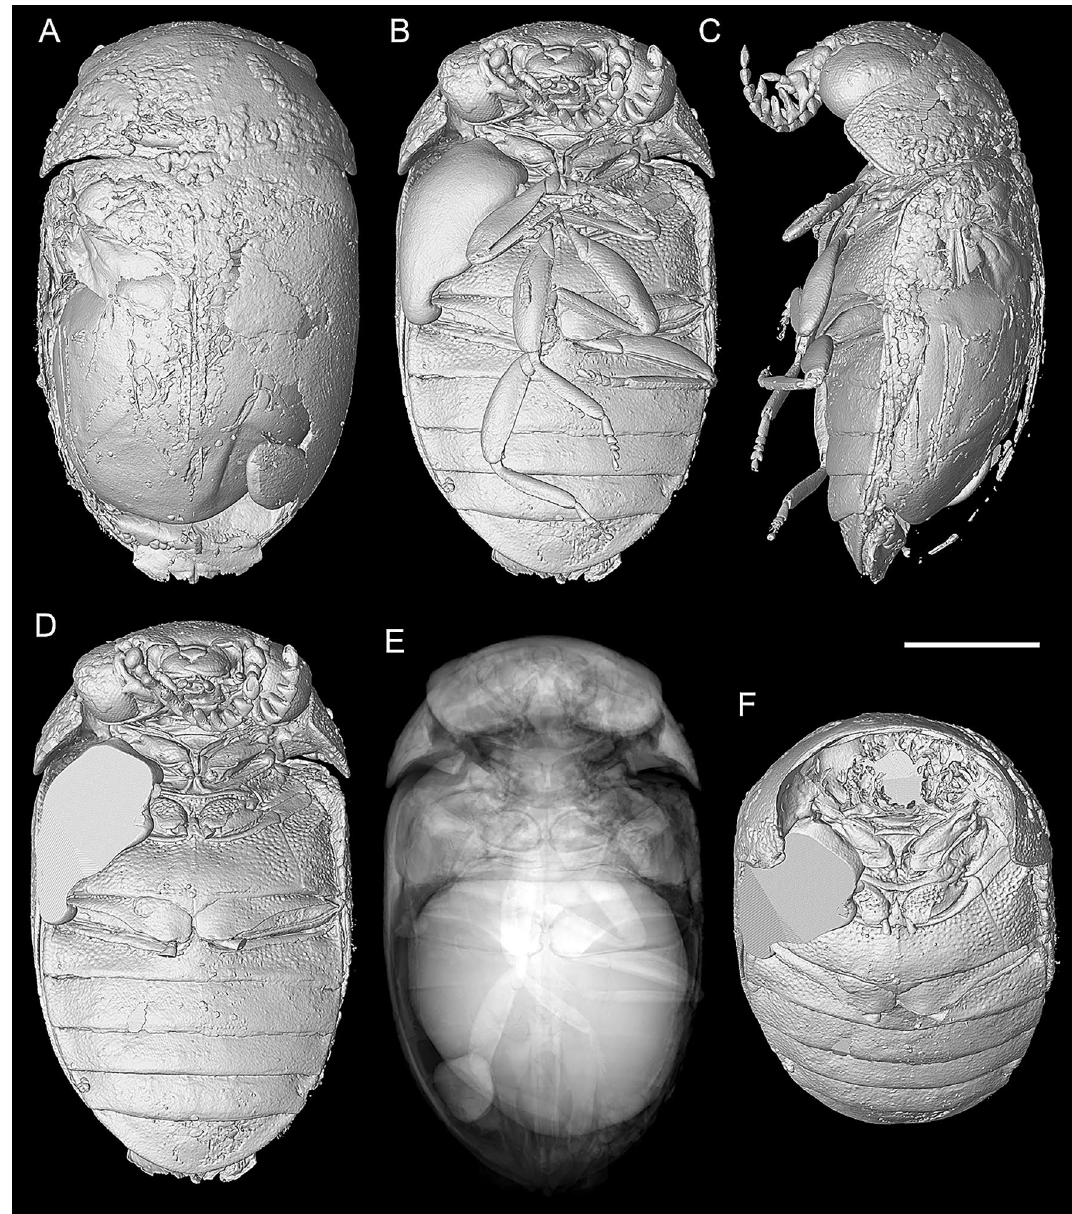
Figure 3. X-ray microtomographic reconstruction of Varcalium lawrencei gen. et sp. nov. , holotype, NIGP177336. ( A ) Dorsal view. ( B ) Ventral view. ( C ) Lateral view. ( D ) Ventral view, with legs removed. ( E ) Ventral view, rendered under “Sum along Ray” mode. ( F ) Anteroventral view, with head removed. Scale bar: 1000